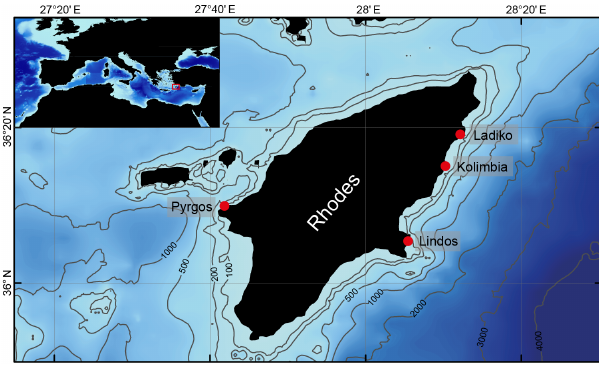
Figure 1. Location of the long-term experiment at Rhodes, Greece, in the Eastern Mediterranean Sea. Between 1982 and 1996, experi- mental blocks were deployed at four sites on the eastern and western coast of Rhodes in 3 to 17 m water depth. Bathymetric data were de- rived from the EMODnet Portal for Bathymetry (EMODnet, 2015).